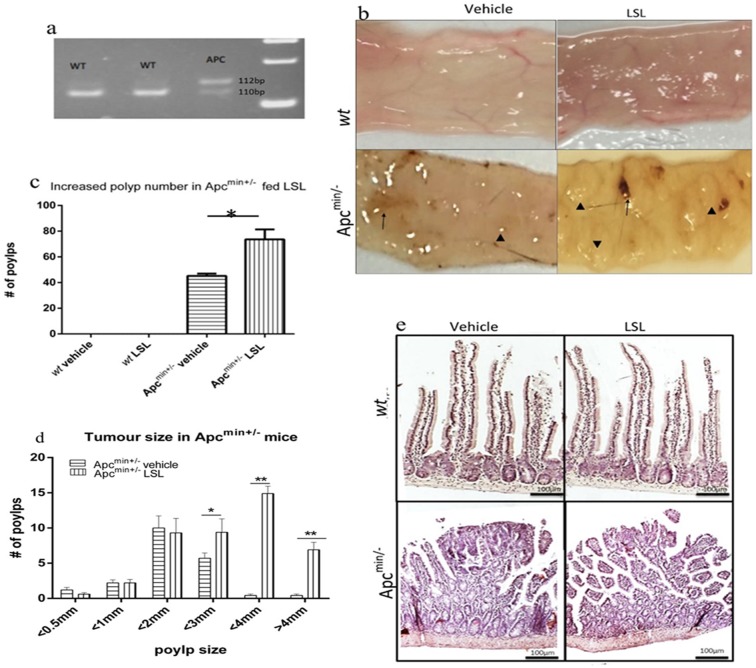
LSL treatment increases tumour number and size in Apcmin+/- mice.PCR and restriction enzyme analysis of genomic DNA from wt or Apcmin+/- littermates (a); wt band: 111bp, heterozygous Apcmin+/- mouse—111 & 123bp. Mice were fed either LSL or vehicle-only every other day for 70 days. Examination of low power images of intestinal segments from wt mice treated with vehicle or 50mg/kg LSL revealed no discernible differences in gross morphology (top). However, in Apcmin+/- (bottom), those treated with vehicle-only (left) showed evidence of occult bleeding (arrow) as well as numerous polyps (c arrow heads) with a modal diameter of 2mm (d). In Apcmin+/- mice treated with LSL, there was evidence of recent hemorrhage (arrows) as well as significant increases in both polyp number (c;*p <0.01) and size (d;**p < 0.001) compared to vehicle-only controls. Values represent mean ± SEM (n = 10/group). Statistical significance was determined by one-way ANOVA (c) or a student T-tests (d). (e) Histological sections from wt (top) or Apcmin+/- (bottom) stained with Haematoxylin and Eosin. Distinct villi in wt treated with vehicle (left) or 50mg/kg LSL are seen. In Apcmin+/- littermate mice villous structure is grossly perturbed within polyps in both vehicle-treated mice (bottom left) as well as those treated with 50mg/kg (bottom right).